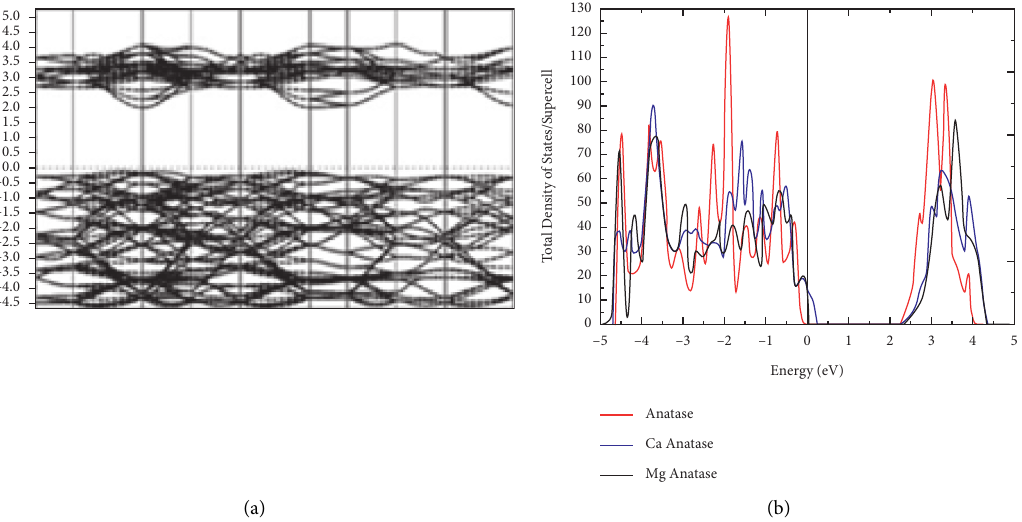
Figure 7: (a) Anatase band structure and (b) TDOS and PDOS of doped and undoped